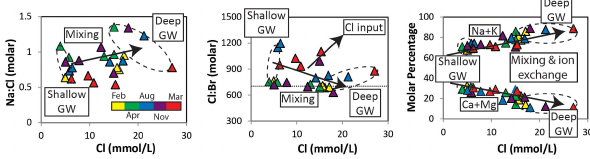
Figure 8. Trends in major ion chemistry at Tambo Upper indicating mixing between groundwater in the shallow, unconfined aquifer and groundwater from the deeper, semi-confined